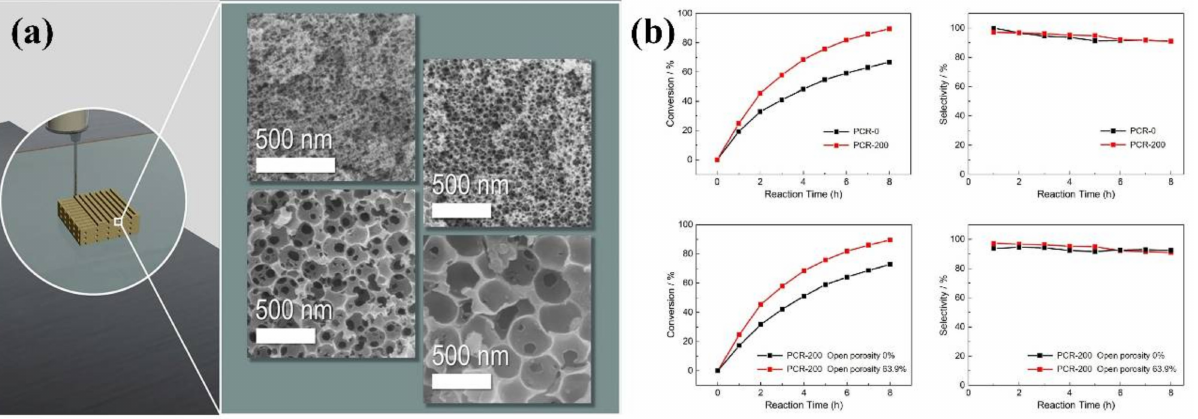
Figure 2. ( a ) Schematic and SEM images of 3D printed porous carbon and ( b ) their catalytic performance [50]. Reproduced with permission from ref. (Zhou et al., 2020) Copyright, 2020, Elsevier